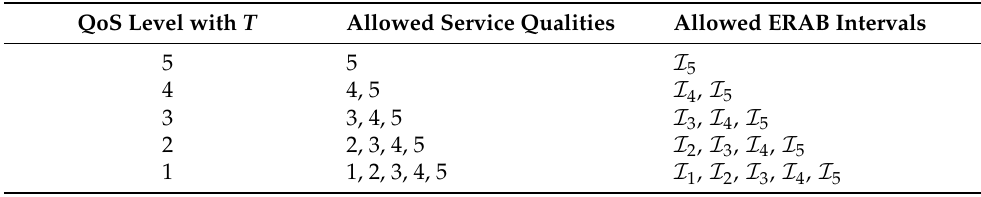
Table 2. An example of a set of QoS levels and their corresponding service qualities and ERAB intervals. This example is based on the service qualities and ERAB intervals defined in Table